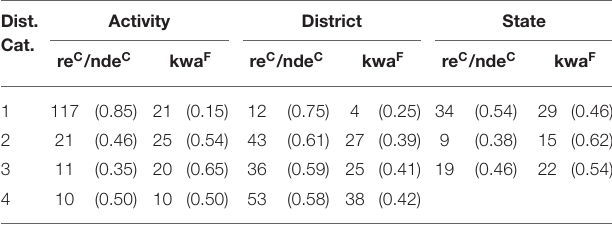
TABLE 5 | Raw frequencies (with proportions in parentheses) of demonstrative forms across distance categories at the activity, district, and state scales. Dist.